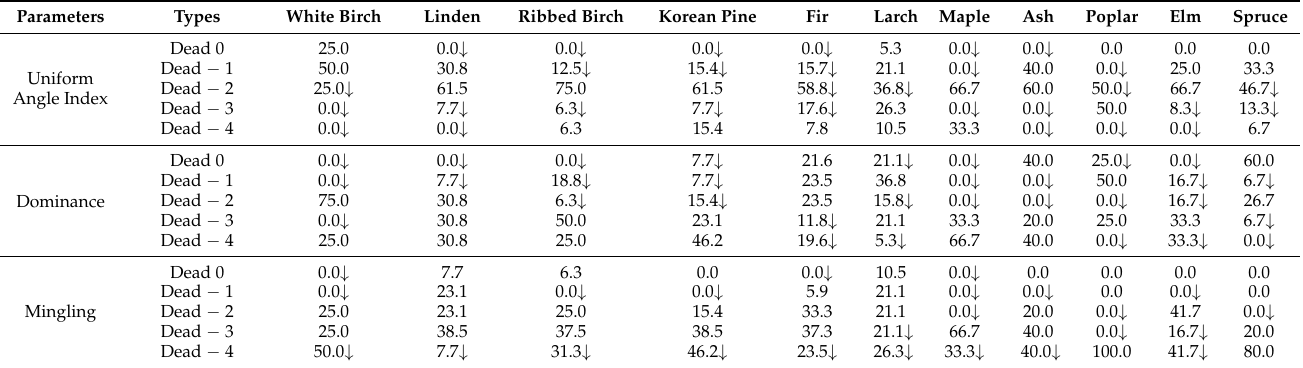
Table A2. The proportion statistics of change types of main tree species in mortality process